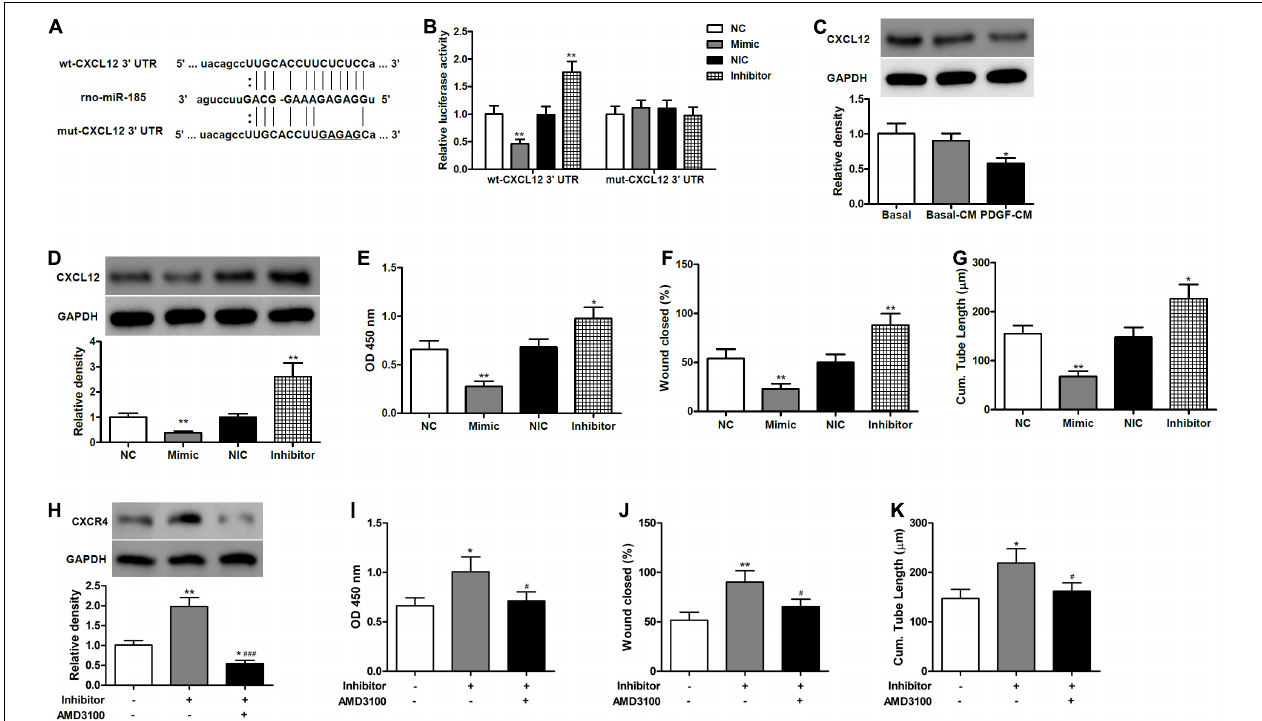
FIGURE 3 | miR-185 directly targets CXCL12 in ECs. (A) The predicted miR-185 target site in the 3 (cid:48) UTR of CXCL12. (B) HEK293 cells were co-transfected with miR-185 mimic or inhibitor together wildtype (wt)- or mutant (mut)-CXCL12 3 (cid:48) UTR construct. Twenty-four hours later, cells were harvested for the determination of luciferase activities. ** P < 0.01 vs. NC or NIC group. (C) Western blot analysis of CXCL12 in ECs treated with different media. * P < 0.05 vs. Basal-CM. (D) Western blot analysis of CXCL12 in ECs transfected with miR-185 mimics and inhibitor for 48 h. (E) Proliferation of ECs transfected with miR-185 mimics and inhibitor was assessed by a BrdU assay. (F) Migration of ECs transfected with miR-185 mimics and inhibitor was assessed by a scratch wound assay. Quantification of migration is expressed as a relative rate of scratch wound healing. (G) Angiogenesis of ECs transfected with miR-185 mimics and inhibitor was assessed by a tube formation assay. Quantitative analysis of the tube lengths is shown. * P < 0.05, ** P < 0.01 vs. NC or NIC group. (H–K) . ECs transfected with miR-185 inhibitor were treated with AMD3100 (5 µ M) for 24 h. Western blot analysis of CXCR4 (H) , proliferation (I) , migration (J) , and angiogenesis (K) of ECs transfected with miR-185 inhibitor and treated with AMD3100 were assessed. * P < 0.05, ** P < 0.01 vs. Blank, # P < 0.05, ### P < 0.001 vs.